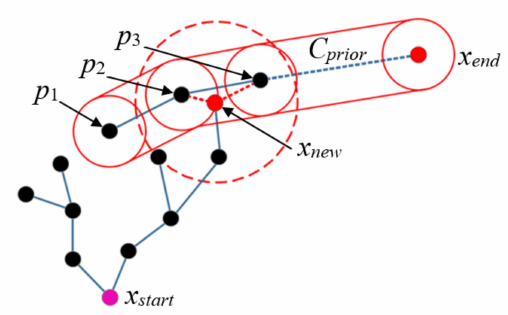
Figure 7. Discovery of the nearest prior